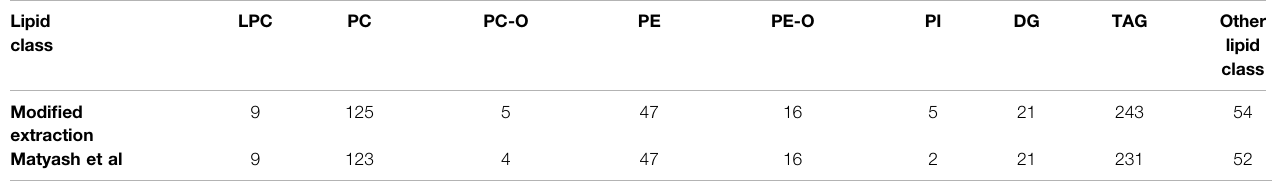
TABLE 3 | Number of annotations in the positive mode for lysophosphatidylcholine (LPC), phosphatidylcholine (PC), ether-linked PCs (PC-O), phosphatidylethanolamine (PE), ether-linked PEs (PE-O), phosphatidylinositol (PI), diglyceride (DG), triacylglyceride (TAG), and other lipid classes. Lipid class